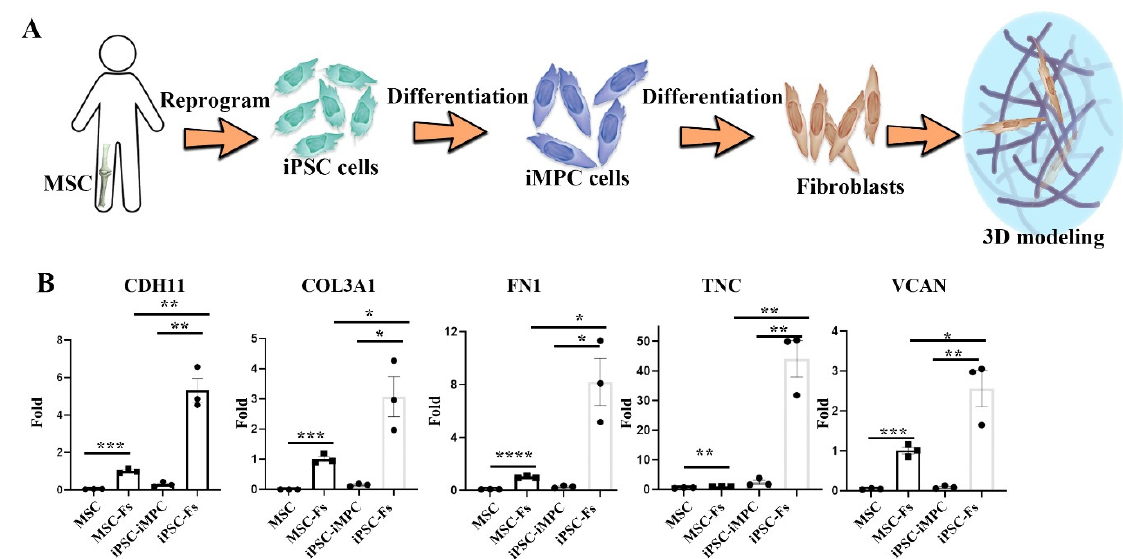
Figure 4. The effects of cPE on iPSC-Fs. ( A ) iPSC cells were differentiated to iMPCs first. Then, the iPSC-Fs were used to model the synovial membrane. ( B ) Expression of fibroblast-associated genes analyzed by qPCR (* p < 0.05, ** p < 0.01, *** p < 0.001, **** p < 0.0001) (values are ±SEM).